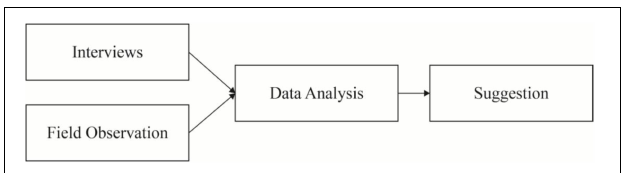
FIGURE 1 | Research methodology employed in the